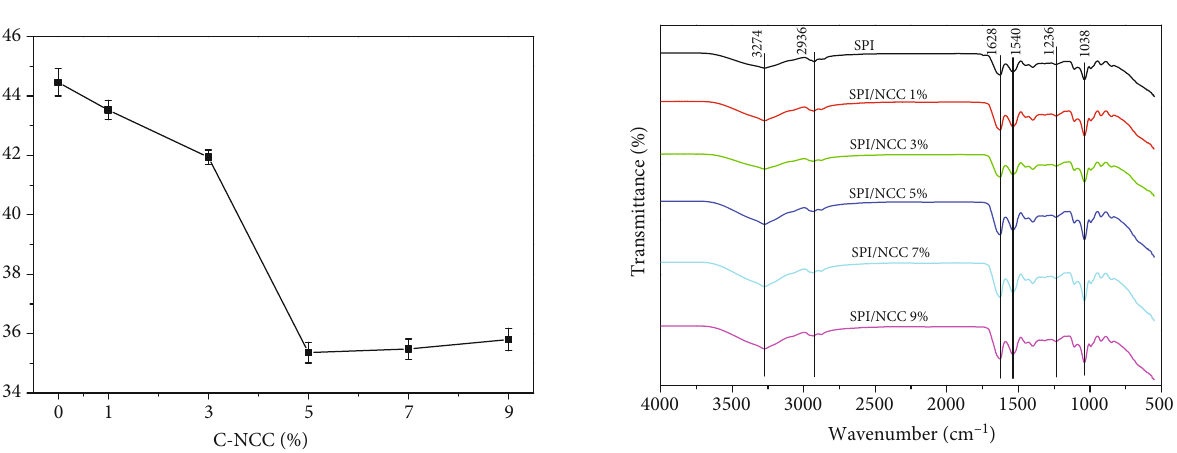
Figure 6: E ff ect of the C-NCC content on the FTIR spectra of the composite fi lms.